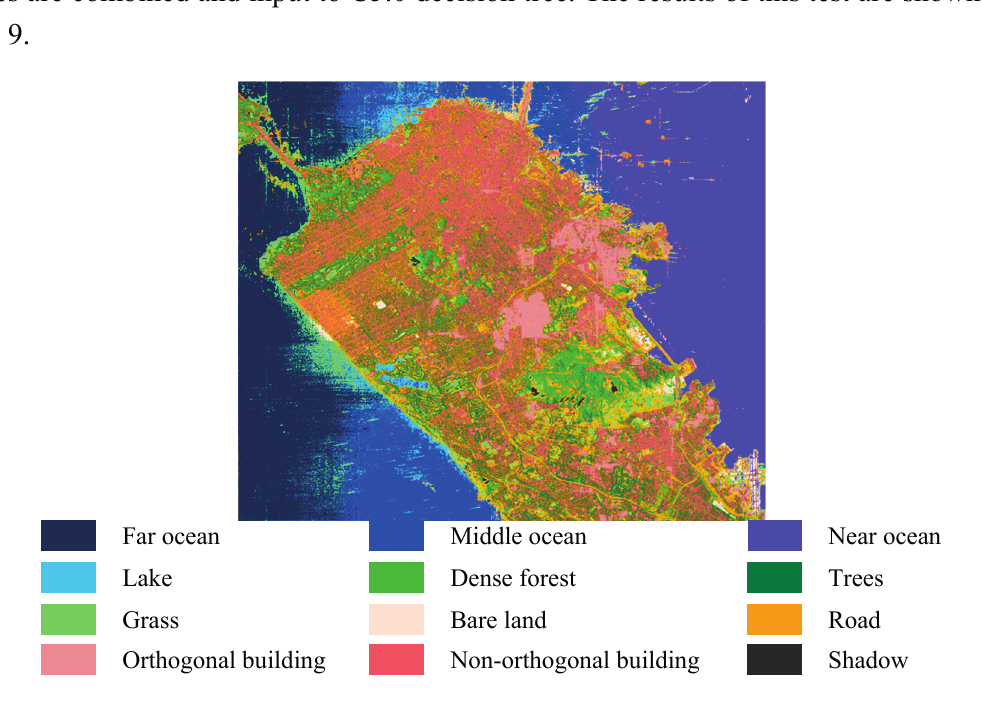
Figure 7. Classification results of adding C- and P-band data to L-band